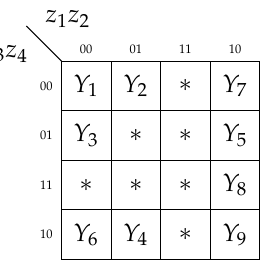
Figure 9. The outcome of encoding of COs for FSM S 1